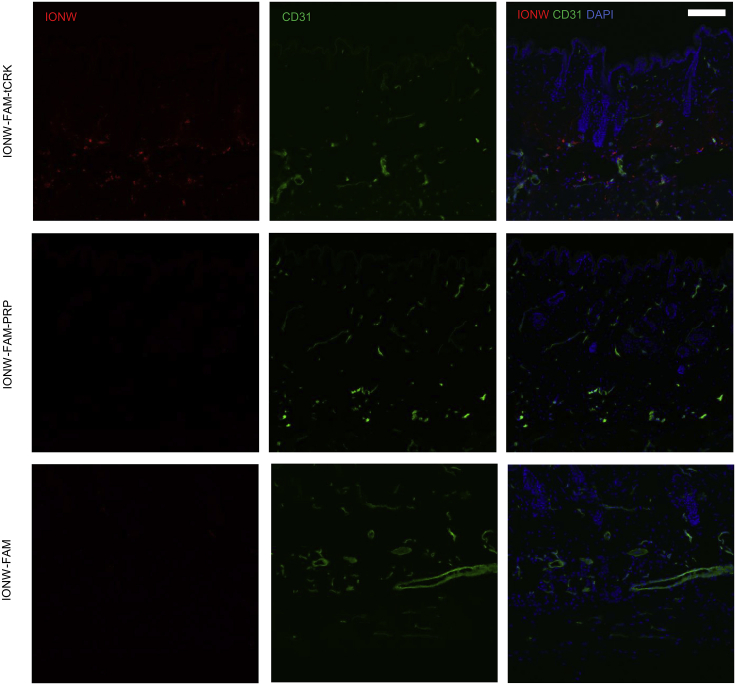
Homing of tCRK-Coated Nanoparticles to Normal SkinRepresentative images of immunohistochemical staining of skin samples from BALB/c mice with anti-FITC (fluorescein isothiocyanate) (red) to detect the intravenously (i.v.) injected FAM-labeled IONWs coated with tCRK (12 mg/kg), a control peptide (PRP) (16 mg/kg), or no peptide (13 mg/kg). The localization of blood vessels is depicted by anti-CD31 (green), and nuclei are stained with DAPI (blue). Scale bar, 100 μm. Representative images are from three independent experiments.